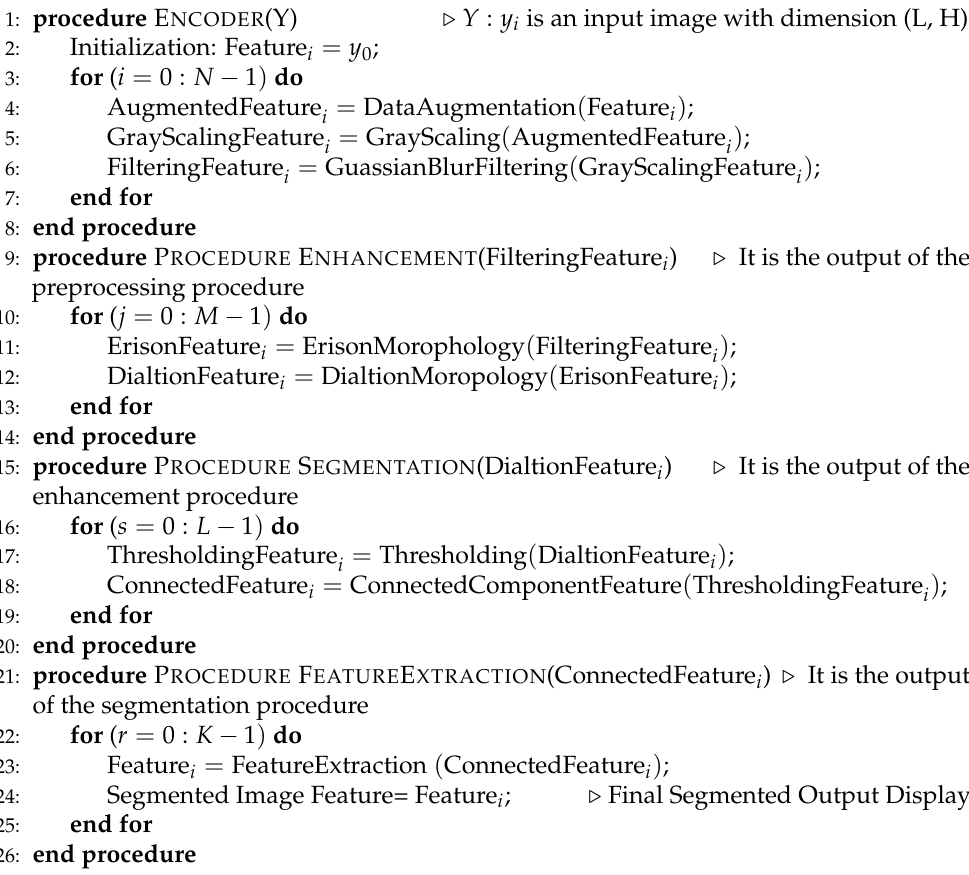
Algorithm 1 Proposed Model for Dental Image